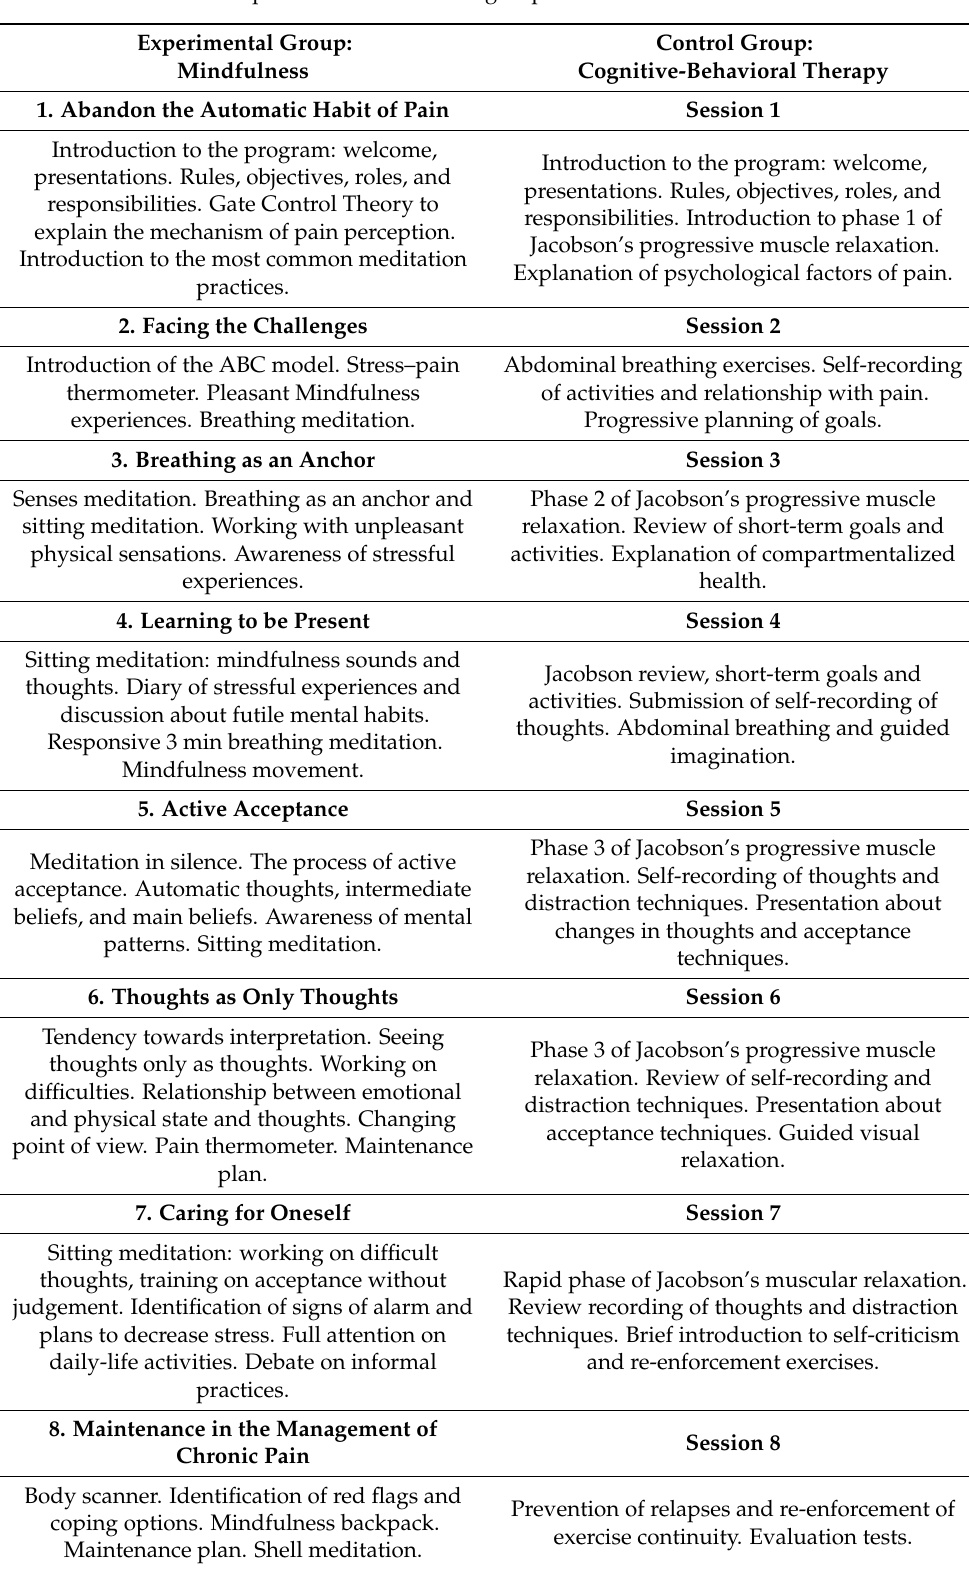
Table 1. Content of the experimental and control group